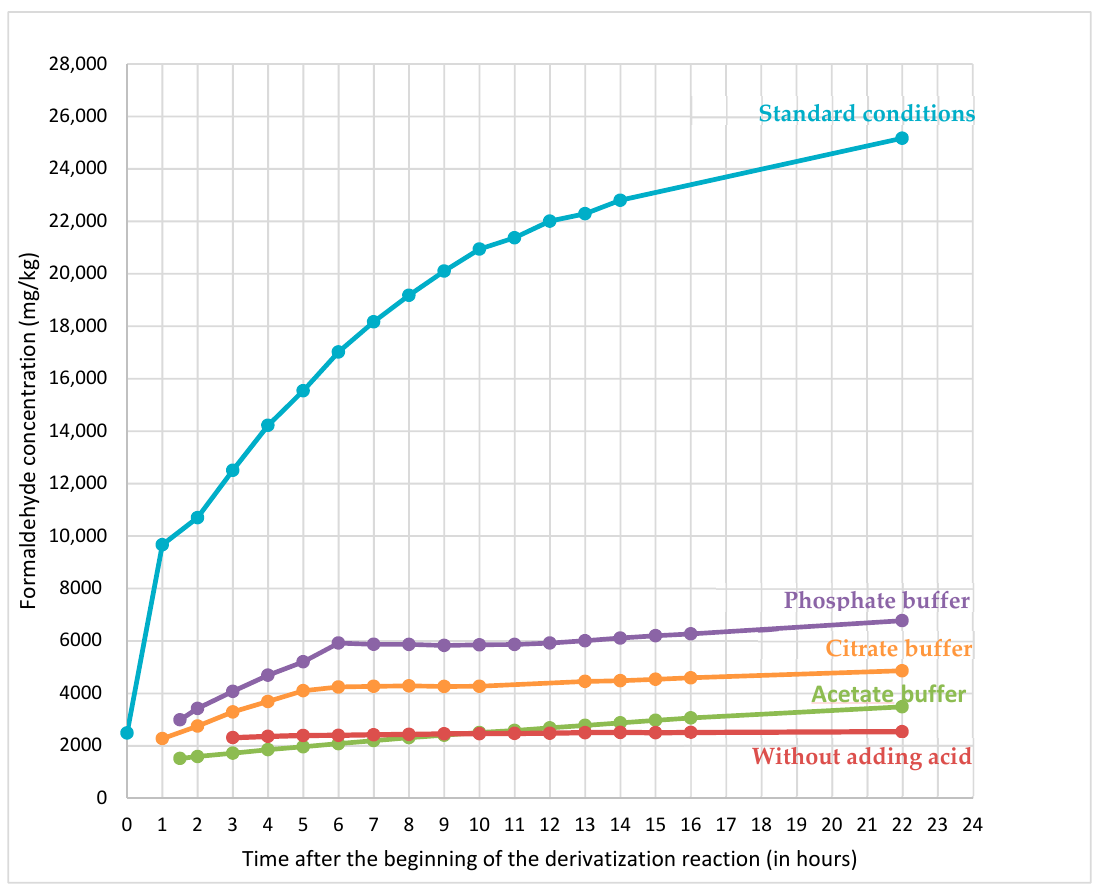
Figure 4. Formaldehyde content measured in dicyandiamide resin pseudo-extracts over derivatization reaction with DNPH in di ff erent derivatization conditions: in blue in standard conditions (EN ISO 17226-1), in purple with phosphate bu ff er, in orange with citrate bu ff er, in green with acetate bu ff er and in red without adding